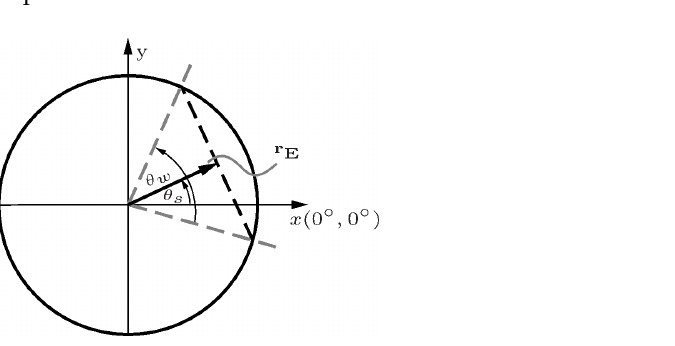
Figure 2. Schematic of the energy vector and its corresponding source angle θ s and source width θ w